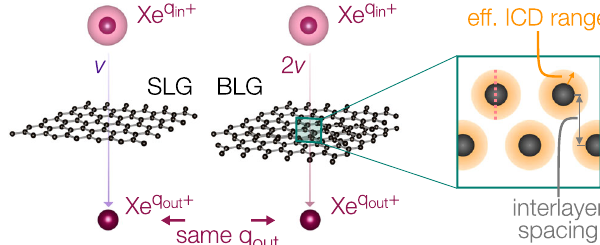
Fig. 6 Schematic of the interaction of highly charged ions and single- layer (SLG) and bilayer graphene (BLG). We fi nd that the exit charge state of the ion depends only on the interaction time spent in close proximity to the material layer, i.e., the charge exchange is the same for an ion with velocity v transmitting through a single layer of graphene and an ion with velocity 2 v transmitting through bilayer graphene. Graphene layers were rendered using the software VESTA 82 . In the zoom-out, the interlayer spacing between two graphene layers and an effective interatomic Coulombic decay (ICD) range are